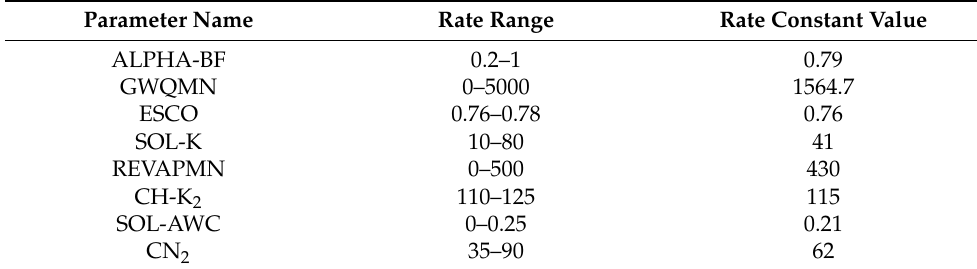
Table 4. SWAT model parameter calibration range and final